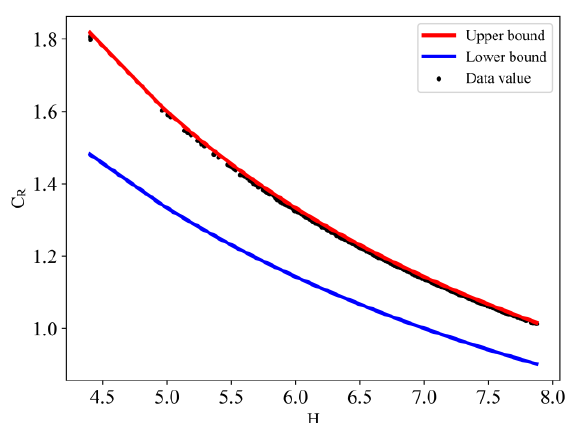
Figure 5. Theoretical bounds of Shannon’s theorem and the scatter plot of H against C R values obtained by Huffman coding